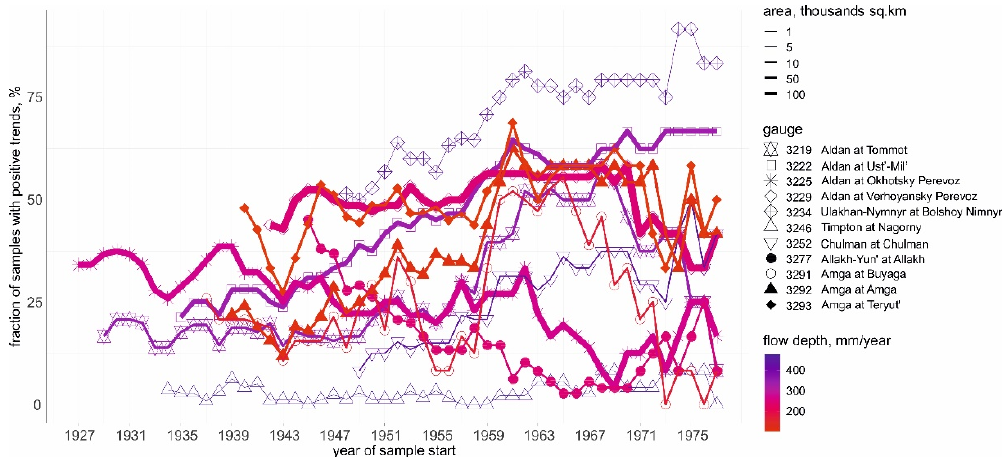
Figure 6. Fraction of samples with positive trends at the studied gauges for different beginning years.